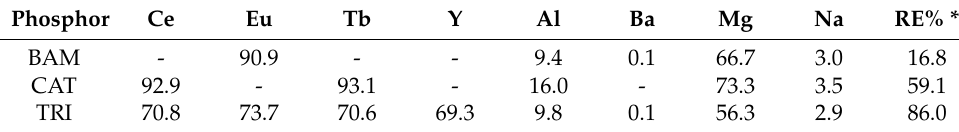
Table 2. Complex leaching efficiency (EFF%) of each metal from the calcined